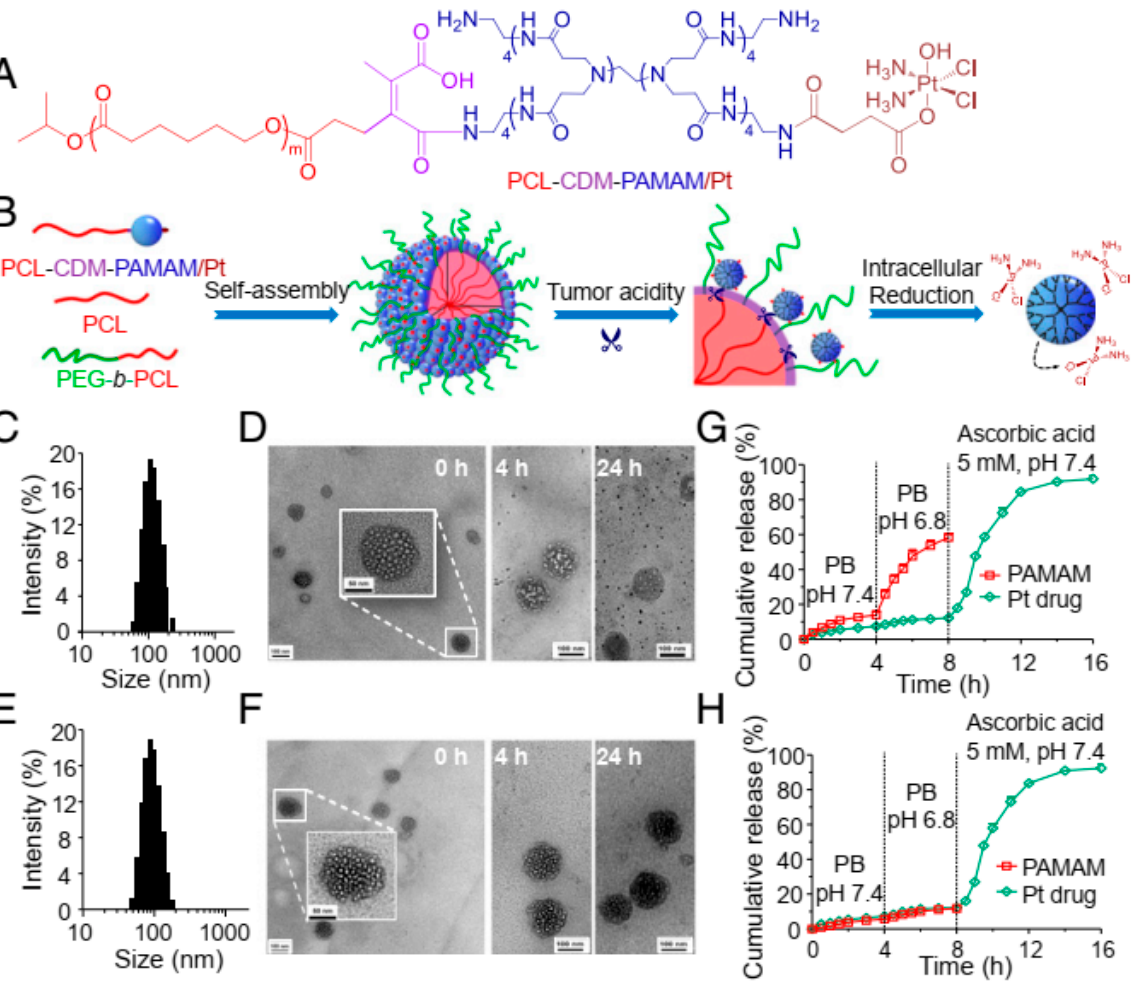
Figure 5. ( A ) The chemistry of PCL-CDM-PAMAM/Pt. ( B ) In accordance with cancer acidosis and the cellular reducing microenvironment, iCluster/Pt self-assembles and alters its structure. ( C ) Size determination of iCluster/Pt and ( E ) Cluster/Pt by dynamic light scattering technique. ( D ) TEM scans of iCluster/Pt and ( F ) Cluster/Pt at pH 6.8 for 0, 4, and 24 h, respectively. (Scale bar, 100 nm and for the Inset images, 50 nm) ( G ) PAMAM and platinum drug release from iCluster and ( H ) Cluster. Re-printed with permission from reference [247]. Copyright (2016), Proceedings of the National Academy of Sciences (PNAS).